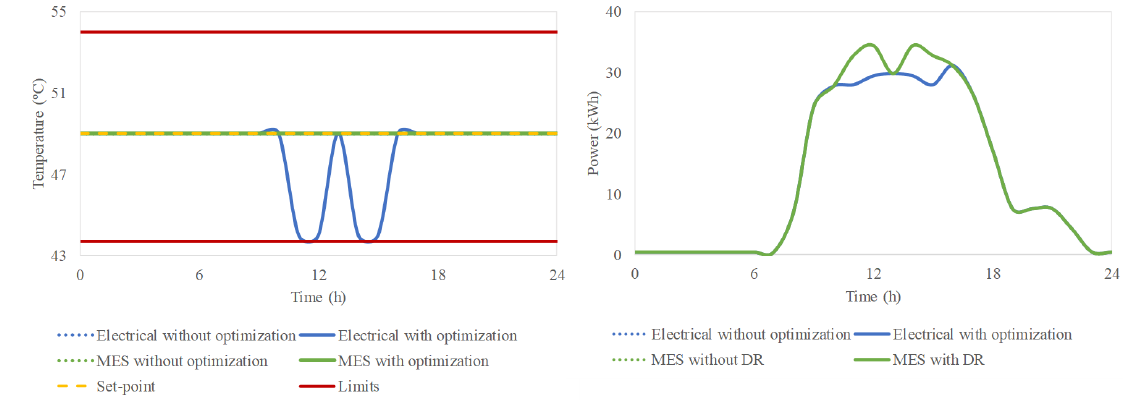
Figure 17. Temperature and power consumed for heating the water in a